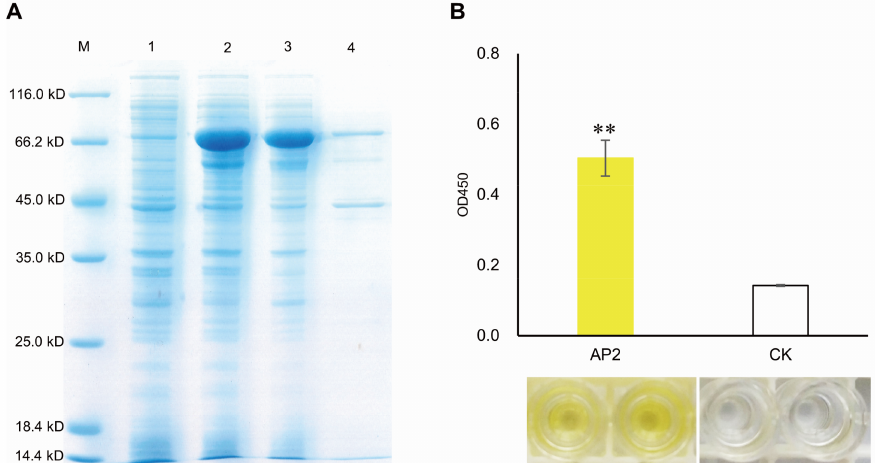
Figure 6. AP2 domain of MeERF72 binding to the promoter of MeSus1 as analyzed DPI-ELISA. ( A ) Over-expression of MeERF72 in E. coli . M: molecular markers, (1) E. coli cells harboring pCold Trigger Factor-AP2 not induced; (2) E. coli cells harboring pCold Trigger Factor-AP2 after 20 h of induction; (3) the clear supernate of total protein from E. coli cells harboring pCold Trigger Factor-AP2 after 20 h of induction; (4) Purified Trigger Factor-AP2 fusion protein; ( B ) AP2 interacts with the MeSus1 promoter by DPI-ELISA assay. AP2: double-strand biotinylated MeSus1 promoter DNA probe + purified Trigger Factor-AP2 fusion protein; CK: double-strand biotinylated MeSus1 promoter DNA probe + trigger factor. Error bars represent the SD of four technical replicates, the significant difference is assessed by ANOVA, ** p <